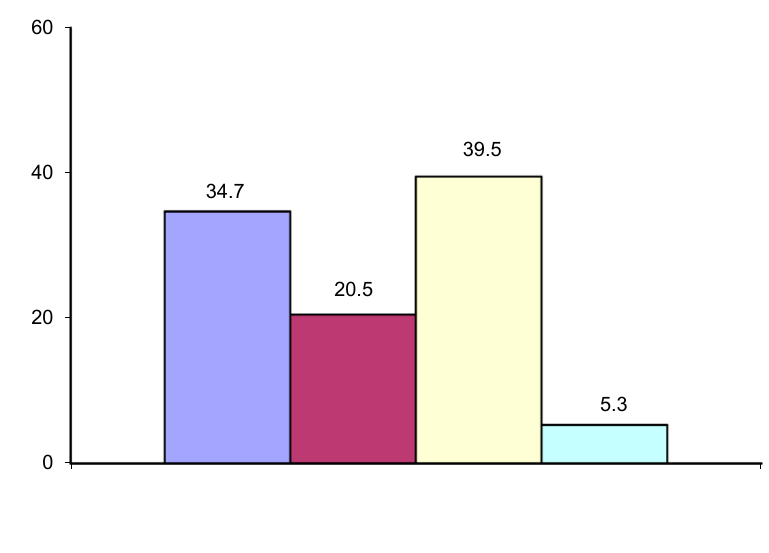
Figure 1. Applied treatment of diabetes mellitus.